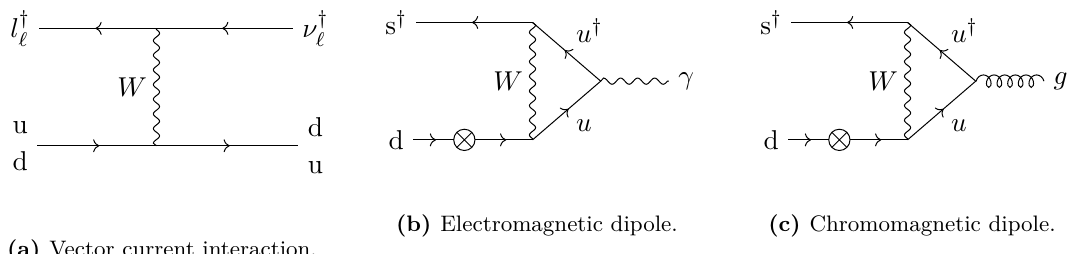
Figure 3. Processes that generate higher dimensional operators at the strong scale with two quarks. Panel a shows the tree level diagram that describes the charged current interaction (2.24). Panels b and c show the 1-loop photon and gluon diagrams that describe the dipole interactions (2.28). The cross indicates a mass insertion that can appear at either external fermion leg. Up type quarks are collectively denoted by u = u, c,